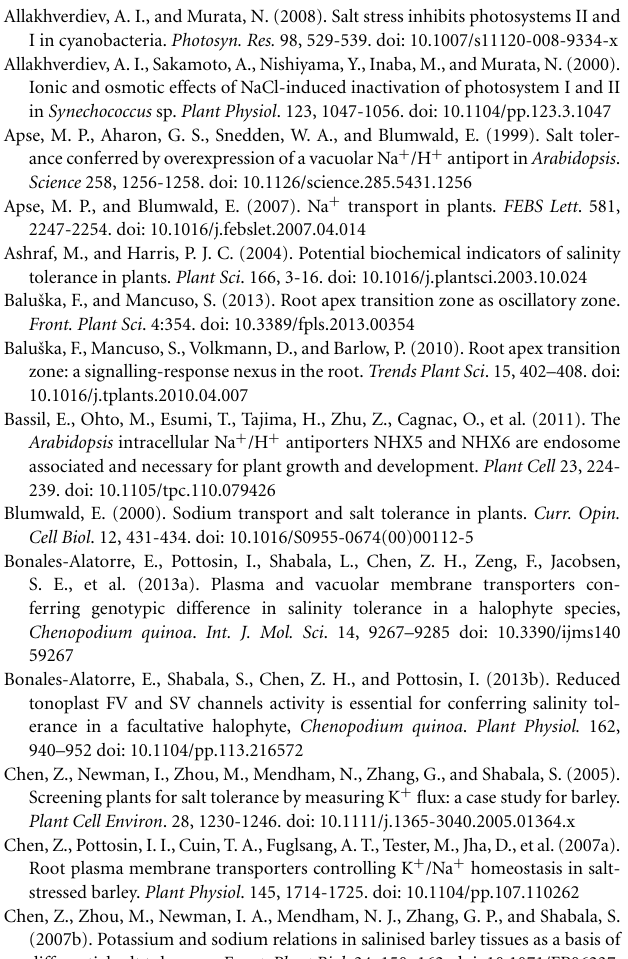
Supplementary Figure S2 | Homogeneity of CoroNa Green fluorescence signal between various cell layers. (A,C) Representative (one of four) images of CoroNa Green fluorescence in the root apex of bread wheat